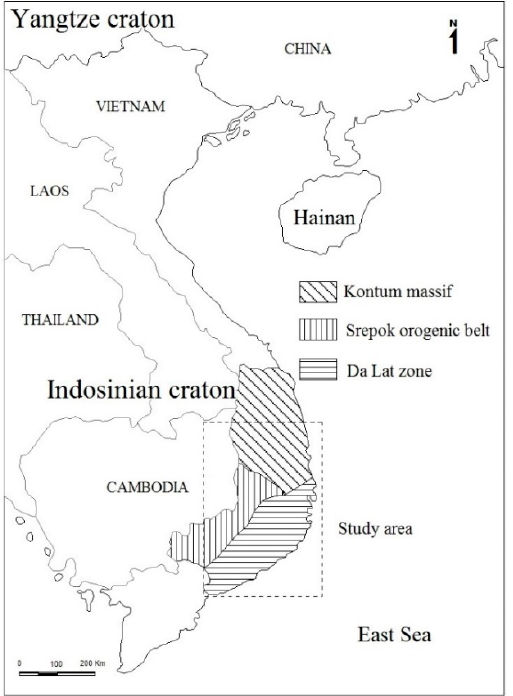
Figure 1. Geological map showing the study area and main tectonic terranes in Southern Vietnam, modified after Tri and Khuc [11] and Hoa et al. [12].